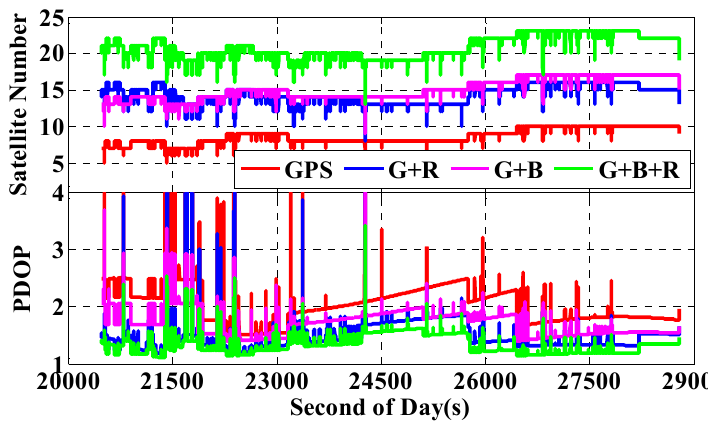
Figure 5. Available satellite numbers ( top ) of GPS, G + R, G + B, and G + B + R, and the corresponding PDOP values ( bottom ) of the vehicle-borne experiment.